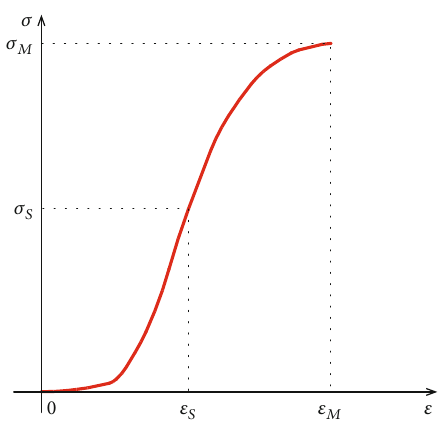
Figure 1: Schematic diagram of the stress-strain curve and in fl ection point of the back fi